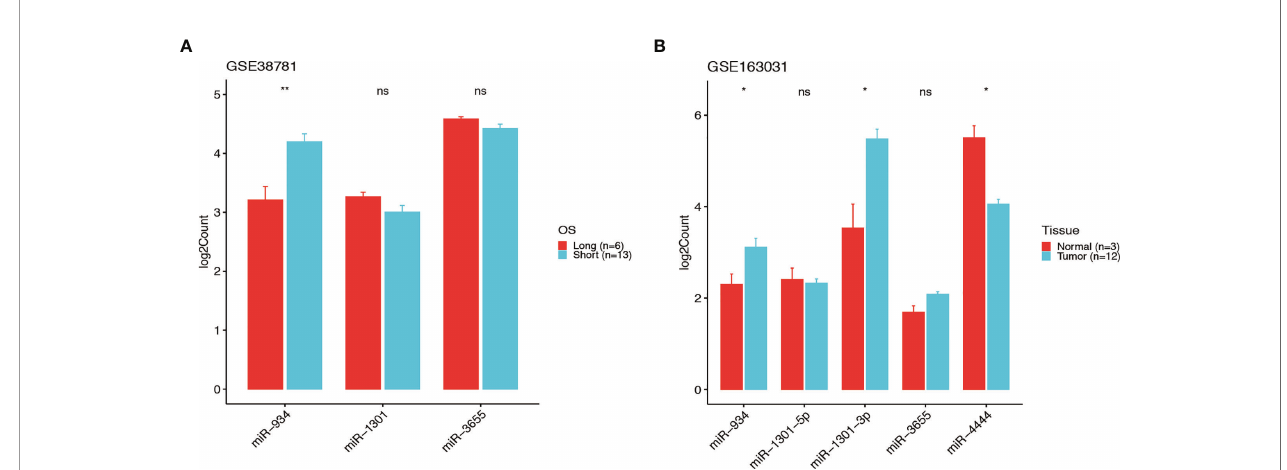
FIGURE 8 | The signature of the 4-miRNA in two GSE database. The expressions of the 4 miRNAs in GEO database GSE38781 and GSE163031 (t test, ns P > 0.05, *P < 0.05, **P < 001). The higher expression of miR-934 and lower expression of miR-1301 and miR-3655 were predicted the poor prognosis in PDAC patients of